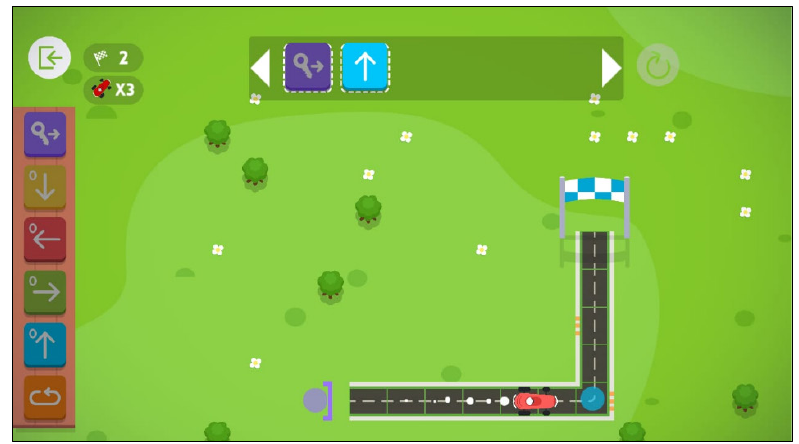
Fig. 4. Interface with the Code Karts game in